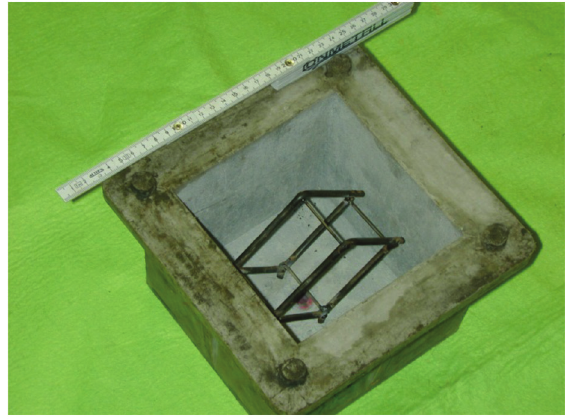
Fig. 1. Spatial arrangement of reinforcement Fig. 2. Arrangement of reinforcement in polymer mould